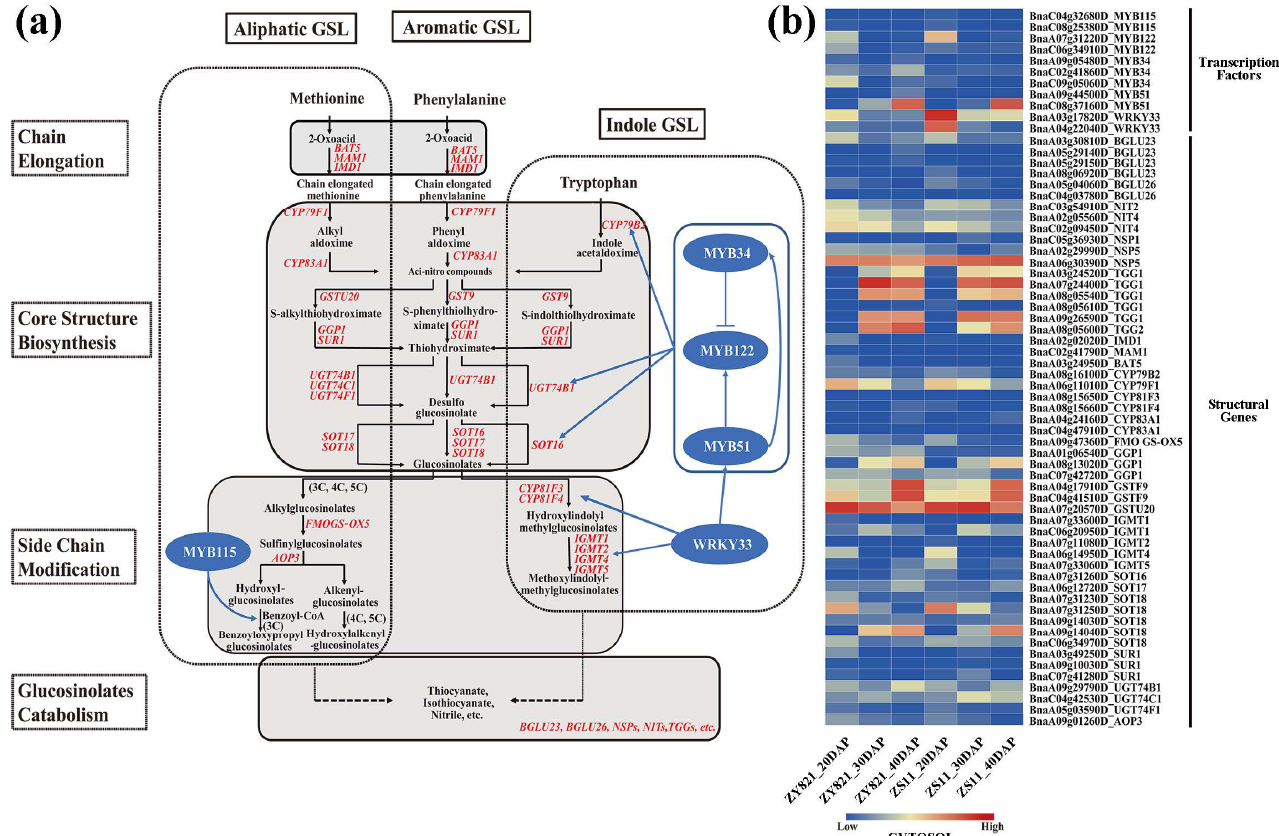
Figure 4. The proposed GSL biosynthesis pathway ( a ) and expression patterns of known candidate genes in B. napus ( b ). The proposed pathway was constructed based on published data [33,38,42,50–53]. BAT, bile acid transporter [54]; IMD, isopropylmalate dehydrogenase [55]; MAM1, methylthioalkylmalate synthase 1 [56]; CYP, cytochrome P450 [57]; UGT, UDP-glucosyl transferase [22,58]; GST, glutathione S-transferase [59,60]; GGP1, gamma-glutamyl peptidase 1 [61]; SUR1, S-alkyl-thiohydroximate lyase [31]; SOT, sulfotransferase [62]; FMOGS-OX, flavin-monooxygenase glucosinolate S-oxygenase [26]; IGMT, indole glucosinolate O-methyltransferase [63]; AOP3, 2-oxoglutarate-dependent dioxygenase [64]; BGLU, β -glucosidase [65]; NSP, nitrile specifier protein [66]; NIT, nitrilase [67]; TGG, thioglucoside glucohydrolase [68]. Genes with red color represent the identified candidate genes for six glucosinolate metabolites (Table S4). The expression levels of the candidate genes in BnLG and BnHG are listed in Table S5. Further, 20, 30 and 40 DAP represent the seeds after 20, 30 and 40 days after pollination, respectively.